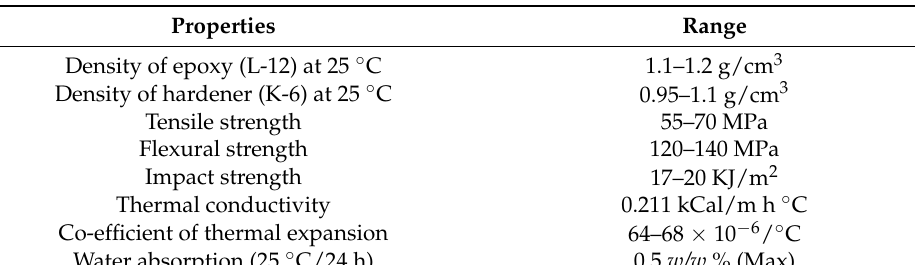
Table 1. Properties of epoxy (As specified by the supplier).